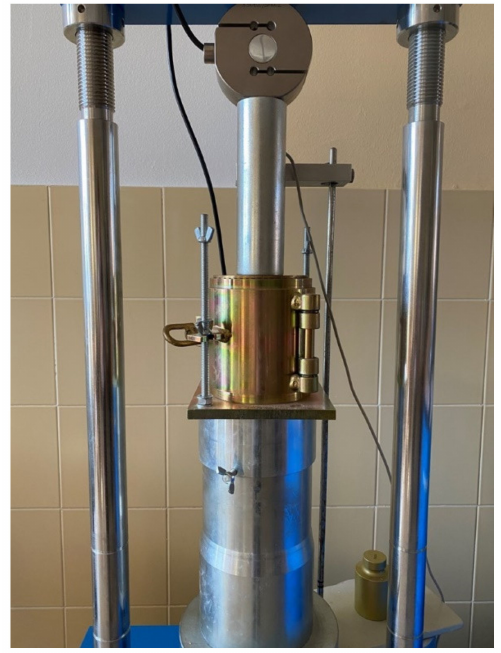
Figure 6. Normal Proctor mould in the multiuse press, used to determine the apparent specific weight of the test materials under normal